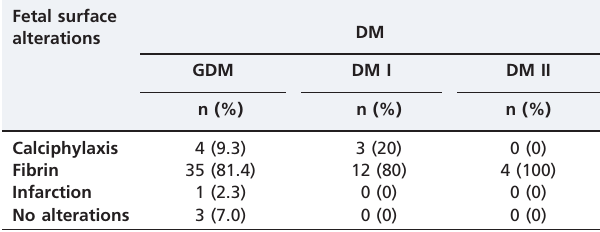
Table 2 - Distribution of placental macroscopic changes on the fetal placental surface in 62 pregnant women with diabetes mellitus from Goiaˆnia, Central-West Brazil, between August 2009 and July 2010.